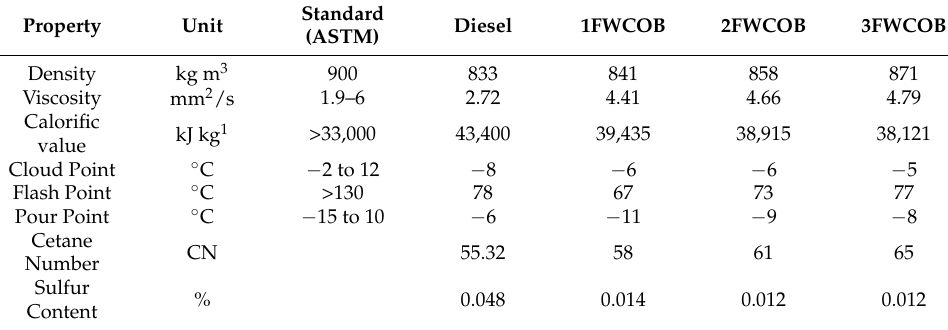
Table 2. Fuel physicochemical